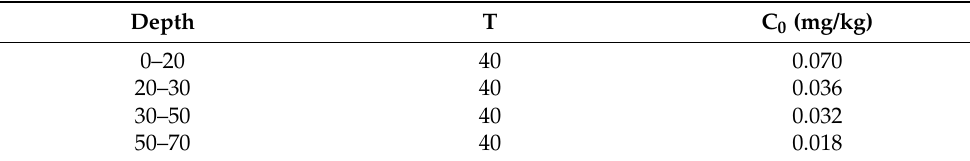
Table 1. Toxicity coefficients of Hg and its reference values.